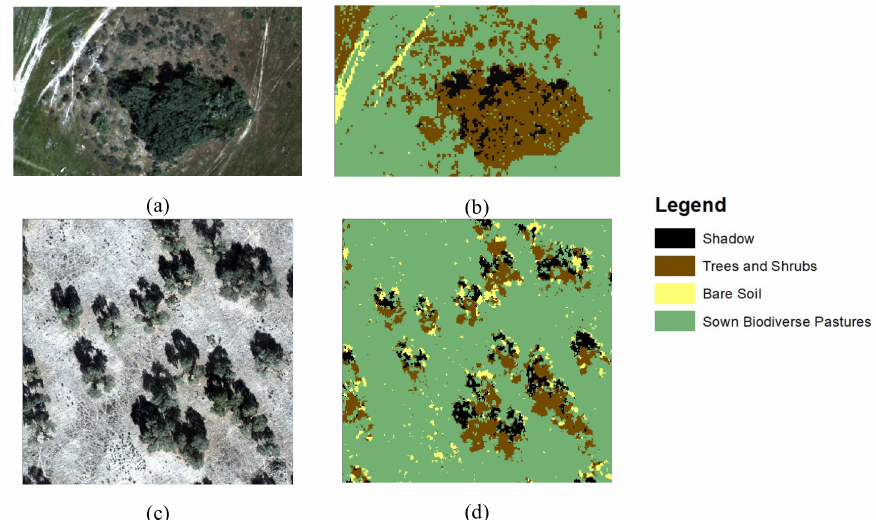
Figure 4. Extract of the aerial photograph of farm 2 ( a ) and respective Random Forest single epoch classification ( b ). Extract of the aerial photograph of farm 1 ( c ) and respective Artificial Neural Network single epoch classification ( d ).